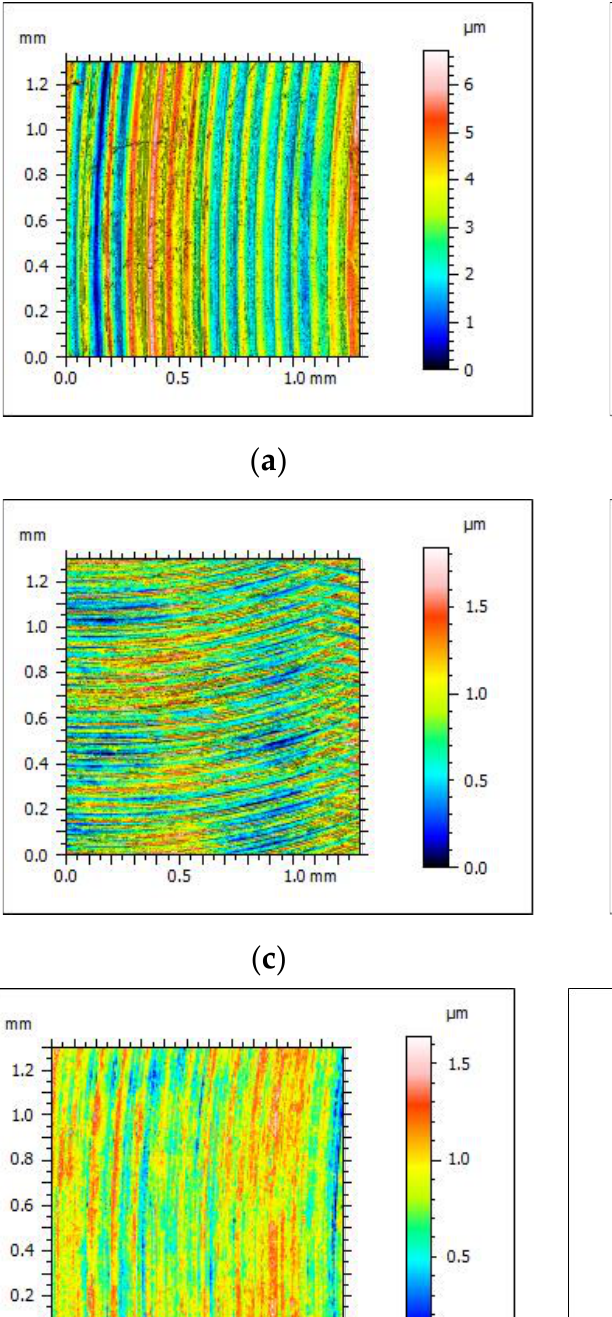
The first pair of samples (1–2) was selected from the part with surface topography parameters belonging to code group A. When analyzing the stabilization stage of the tightness test for the study of the first test case, for the first pair of samples, i.e., the lowest pressing force equal to 890 ± 70 N, a slight pressure drop was noticeable during the